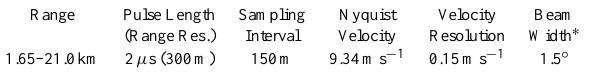
Table 1. Overview of the NERC MST Radar, Capel Dewi, Aberys- twyth,